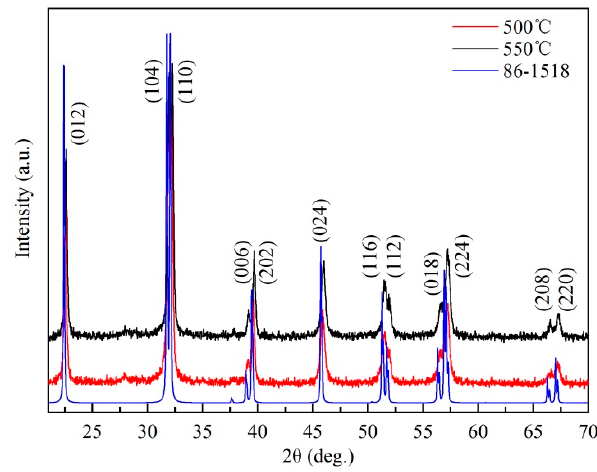
Figure 3. The XRD patterns of BiFeO 3 nanocrystals.